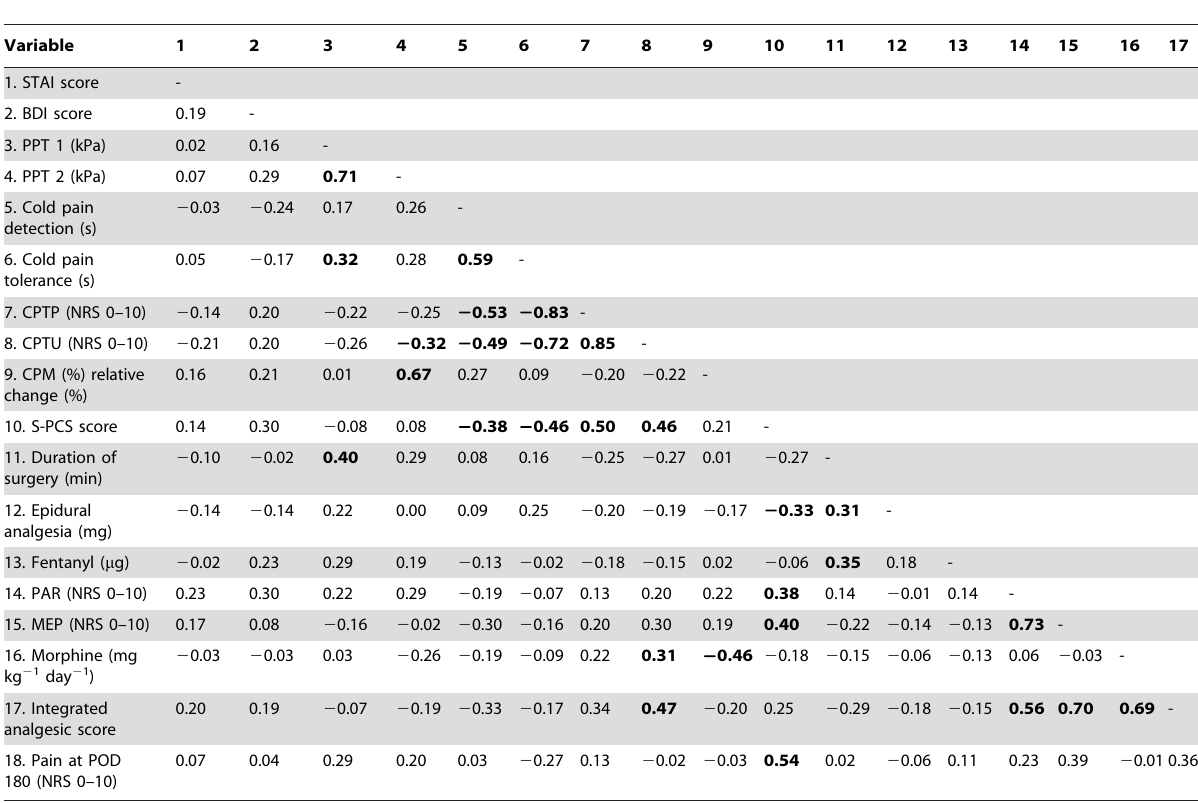
Table 2. Spearman’s Rank Correlation Matrix for Preoperative, Perioperative, and Postoperative Study Variables Including Predictors, Confounders and